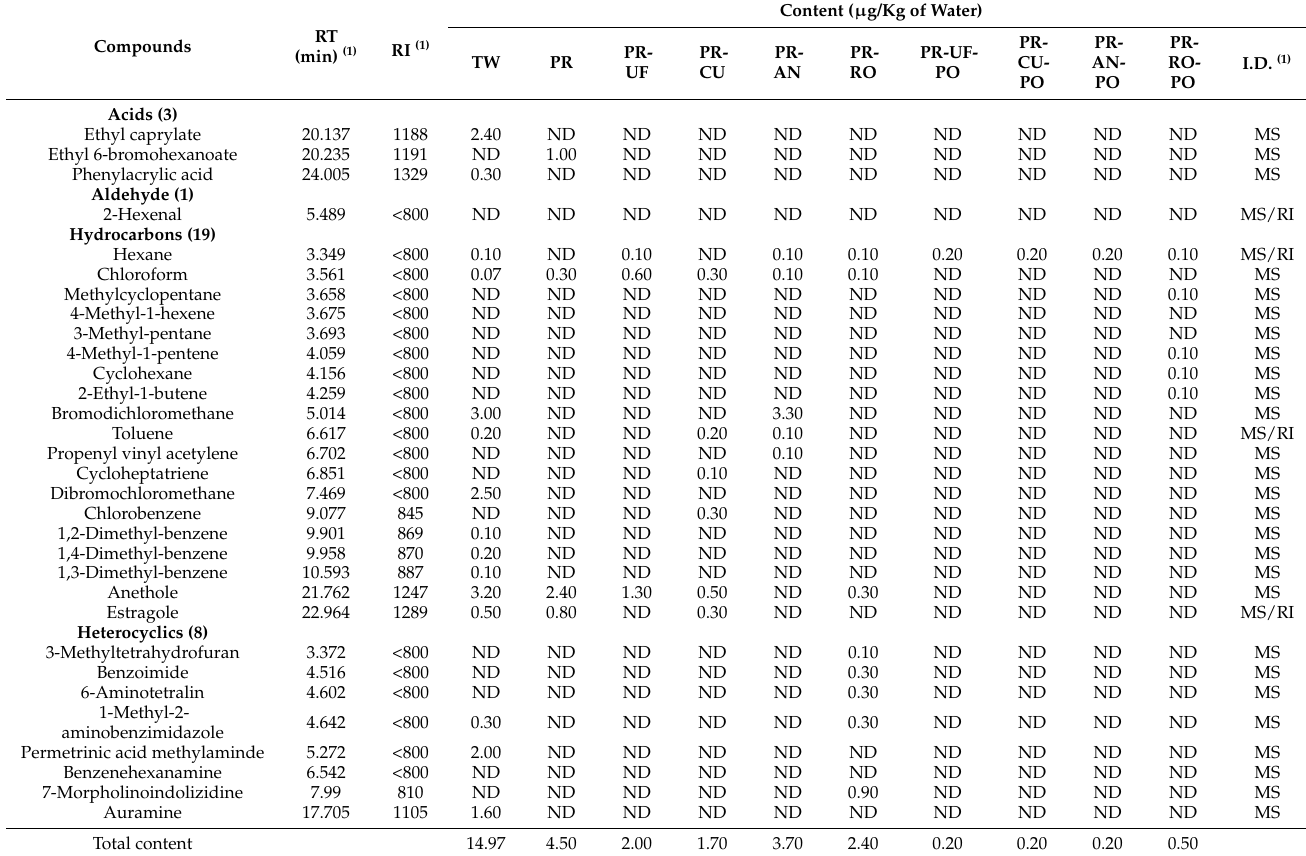
Figure 2. Biplot of the principal component analysis of purified water from mineral and anion contents. Ellipses represents sample clusters from the agglomerative hierarchical clustering analysis. Sample codes refer to Figure 1. Table 2. Volatile organic compounds in 11 water samples using